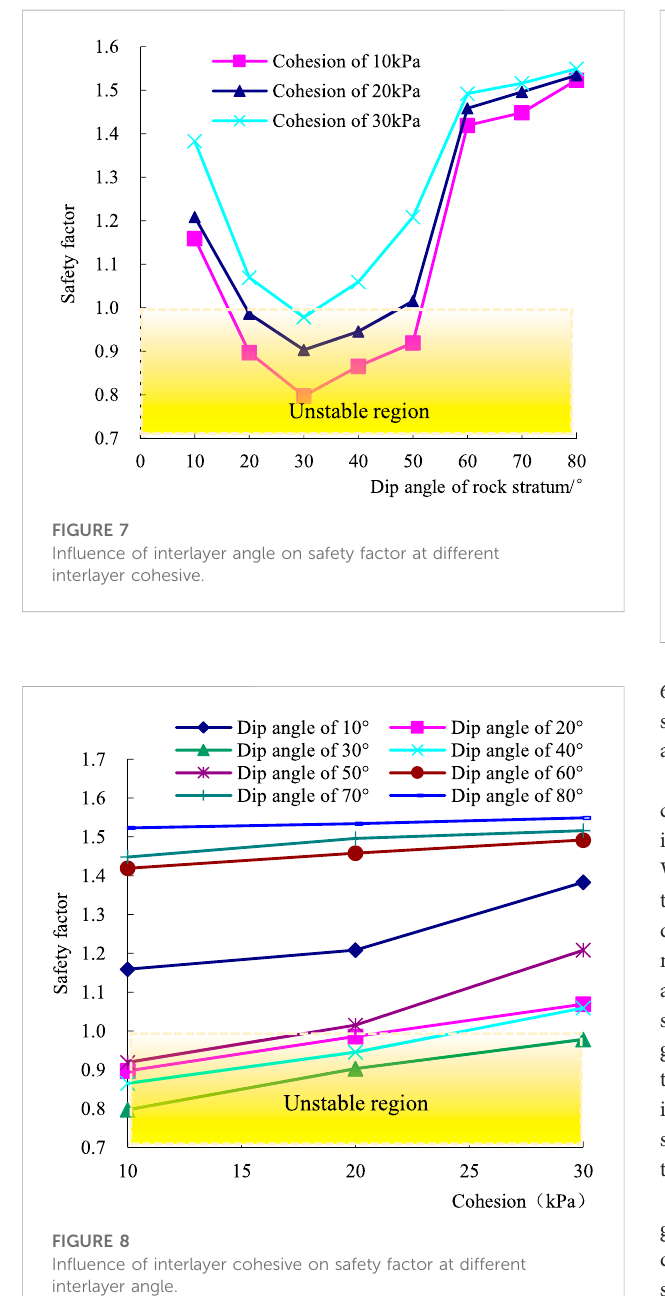
FIGURE 8 In fl uence of interlayer cohesive on safety factor at different interlayer angle.